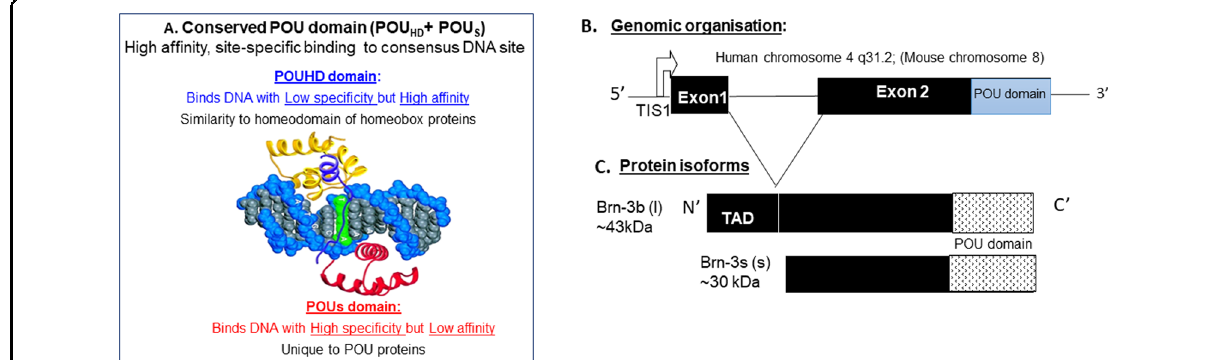
Fig. 1 Schematic fi gures showing the structure of the POU domain, genomic organisation of the Brn-3b gene and proteins arising from this gene. A Diagram showing a schematic model of the DNA-binding POU domain in Brn-3b TF, which is unique to the POU family of transcription factors. This domain consists of the POU HD which binds to the major groove of the DNA double helix with high af fi nity but low speci fi city while the POU-speci fi c domain (POUs), which is unique to POU proteins, binds to DNA with high speci fi city but low af fi nity. The POUs and POU HD domains are tethered together by a poorly conserved linker and together these domains confer high speci fi city and high-af fi nity DNA binding to sites in gene promoters. POU HD POU homeodomain, POU S POU-speci fi c domain. B Schematic diagram showing the genomic organisation of the Brn-3b locus on human chromosome 4 (mouse chromosome 8). C Schematic diagram showing Brn-3b protein isoforms, with splicing of exons 1 and 2 giving rise to the longer Brn-3b(l) while the shorter Brn-3b(s) protein is encoded by exon 2 and therefore contains the POU domain but lacks the amino-terminal transactivation domain (TAD) found in the Brn-3b (l). Approximate sizes of the proteins are indicated. TIS transcription initiation site, TAD transactivation domain, N ’ = amino terminal, C ’ carboxy